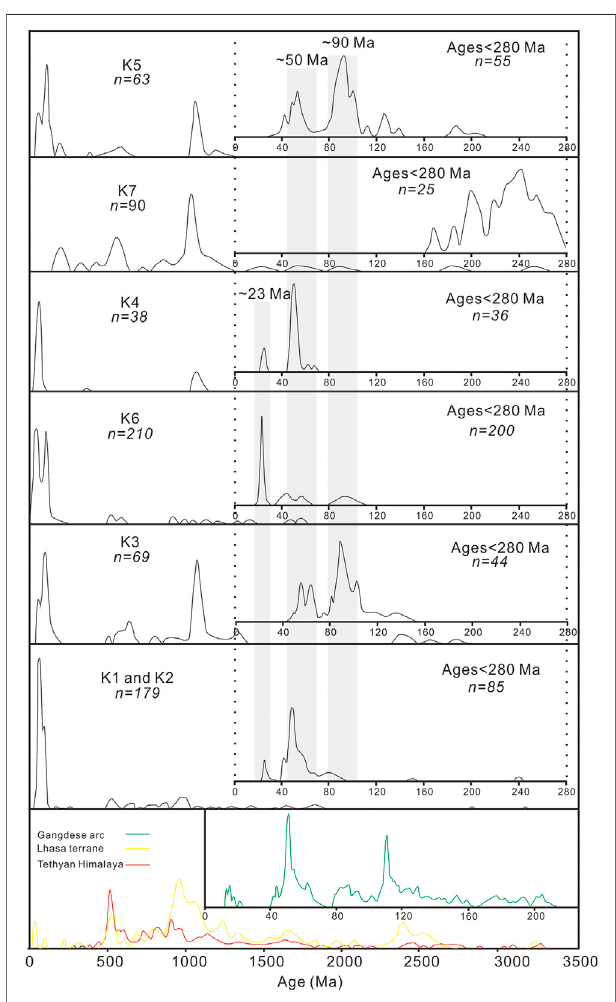
FIGURE 8 | Normalized probability plots for Gangdese conglomerate from seven sections investigated in this study. Gangdese arc, Lhasa terrane, and Tethyan Himalaya data were collected from DeCelles et al. (2004), Chu etal.(2006),Kappetal.(2007),Wenetal.(2008),Jietal.(2009),Huetal. (2010, 2012), and Wang et al.